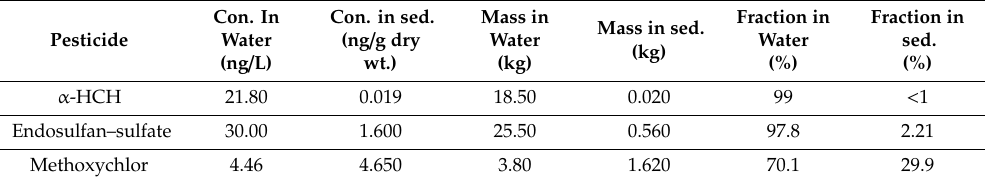
Table 3. Predicted concentration of the OCPs